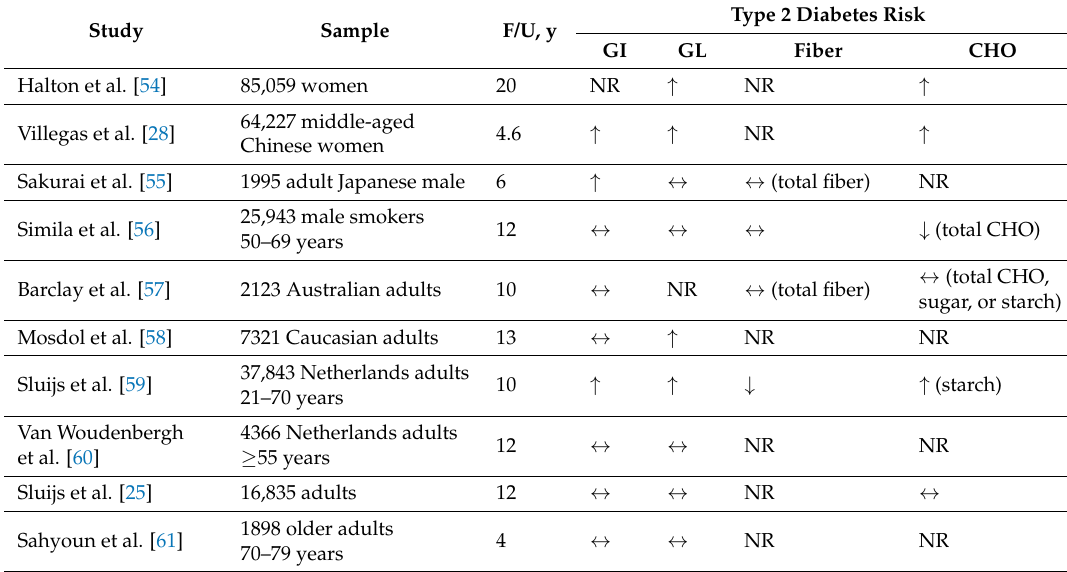
Table 6. Prospective studies assessing the effects glycemic index or glycemic load on type 2 diabetes risk 1